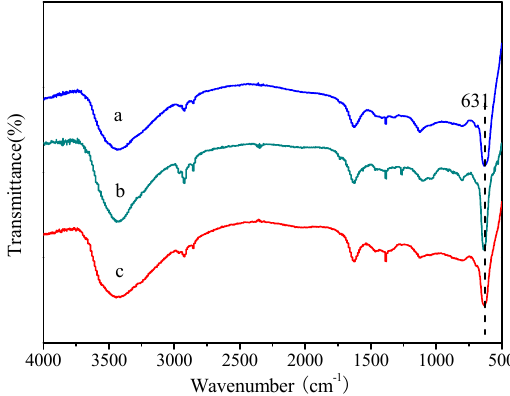
Figure 2. Fourier ‐ transform infrared (FTIR) spectra of ( a ) Cu 2 O ‐ NO 3 , ( b ) Cu 2 O ‐ Cl(1), and ( c ) Cu 2 O ‐ Cl(2).